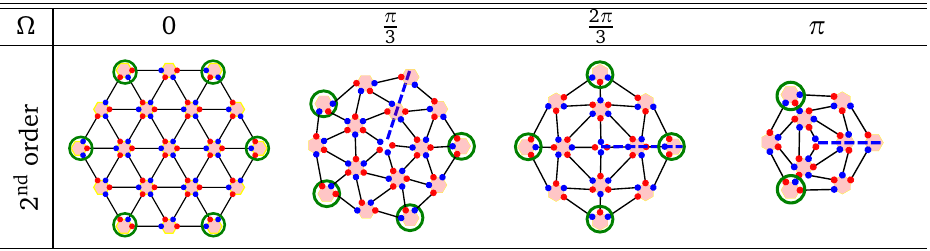
Figure C.6: Sixfold rotation symmetric lattice with disclination with Frank angle Ω decorated with a second-order topological phase whose d − 2 dimensional anomalous states have (cid:90) topological charge. Note for the lattice with π/ 3 or π disclination that it is impossible to choose a decoration along the cut line that preserve the sixfold rotation symmetry. In these cases we omit the decoration of the ( d − 1 ) -cells along the cut line. For the 2 π/ 3 disclination the unique decoration pattern of the second- order topological phase is